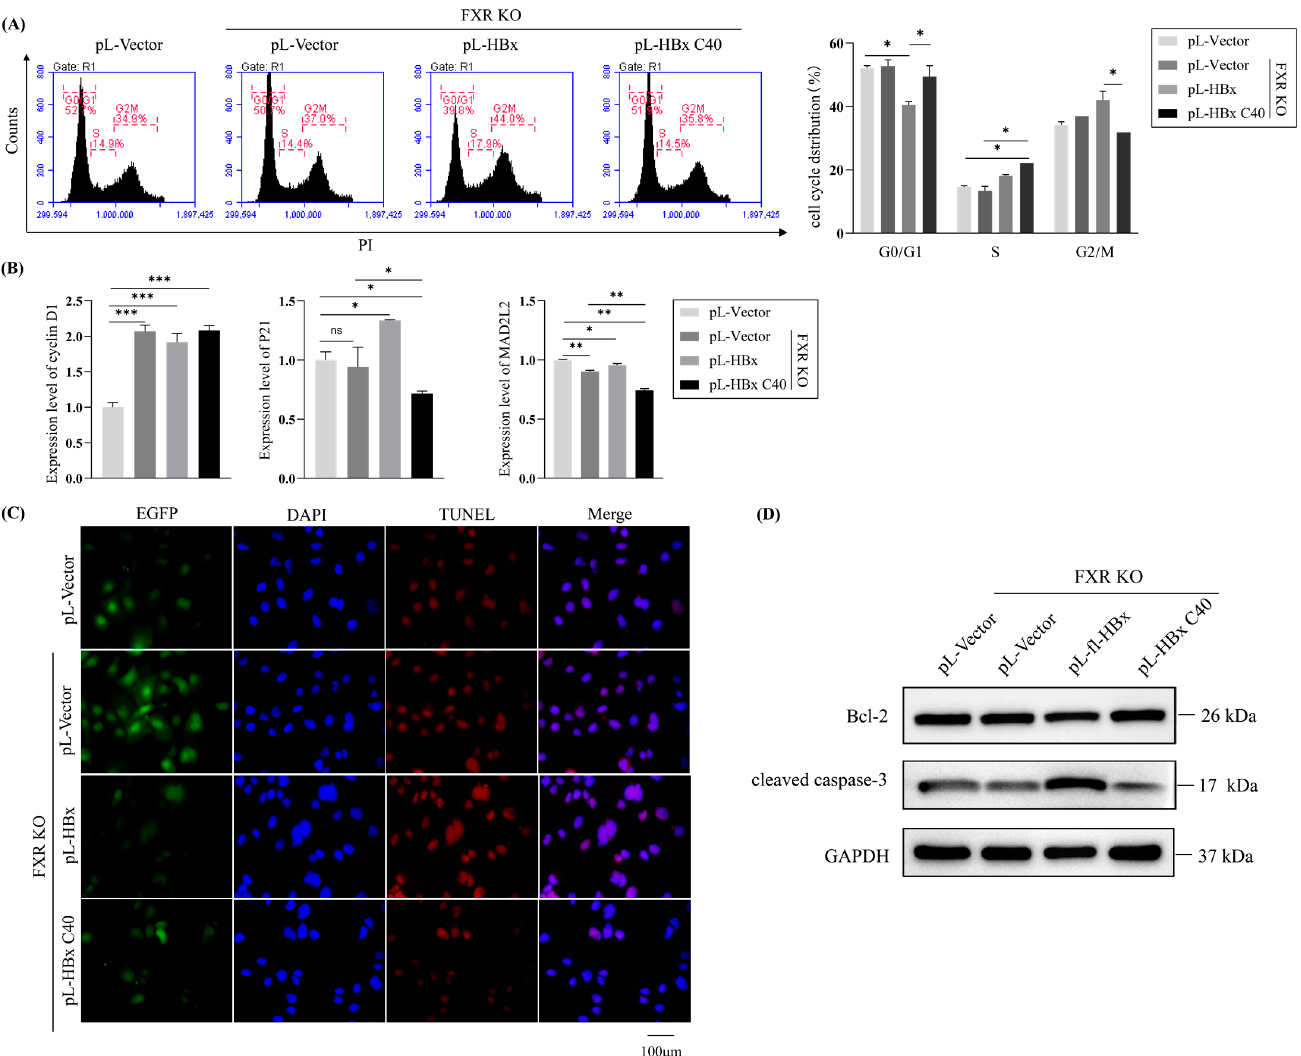
Figure 3. Impact of HBx C40 on the cell cycle and apoptosis in FXR-deficient Hep3B cells. ( A ) Flow cytometry was analyzed to assess the impact of HBx or HBx C40 on the cell cycle in FXR KO Hep3B cells. ( B ) The mRNA expression of cycle-related genes cyclin D1, P21, and MAD2L2. ( C ) TUNEL assay showing the effect of HBx or HBx C40 on apoptosis in FXR KO Hep3B cells. ( D ) Protein expression of Bcl-2 and cleaved caspase-3 after overexpressing HBx or HBx C40 in FXR KO Hep3B cells. * p < 0.05, ** p < 0.01, *** p <